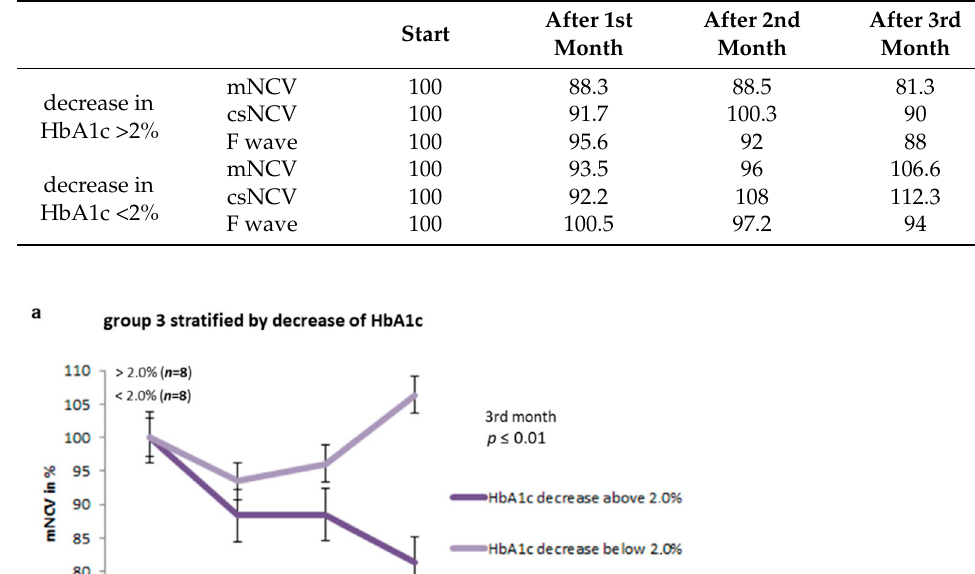
Table 4. Averaged values of mNCV (motor nerve conduction velocity), csNCV (combined sesorimotor nerve conduction velocity) and minimum F wave latencies for group 3 over three months stratified by the decrease in HbA1c levels (>2%, n = 8; <2%, n = 8) each shown as normalized to 100% of the initial value.